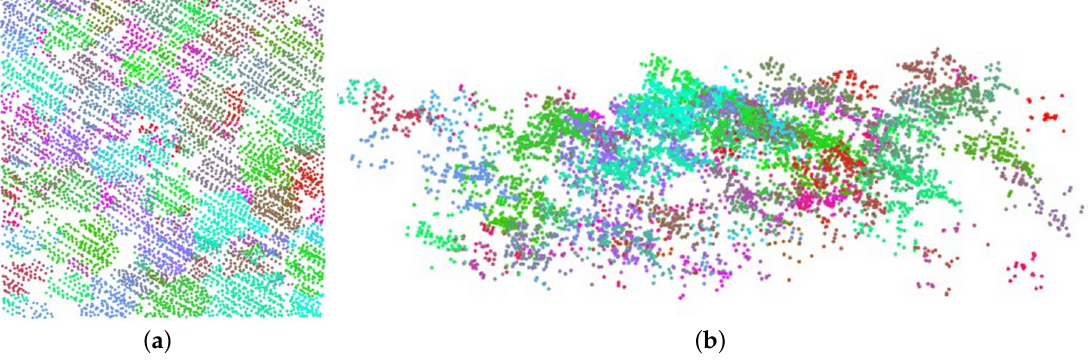
Figure 6. An example of the ultimate clustering results for the point cloud in the test subplot of DHS0201. ( a ) Top view. ( b ) Side